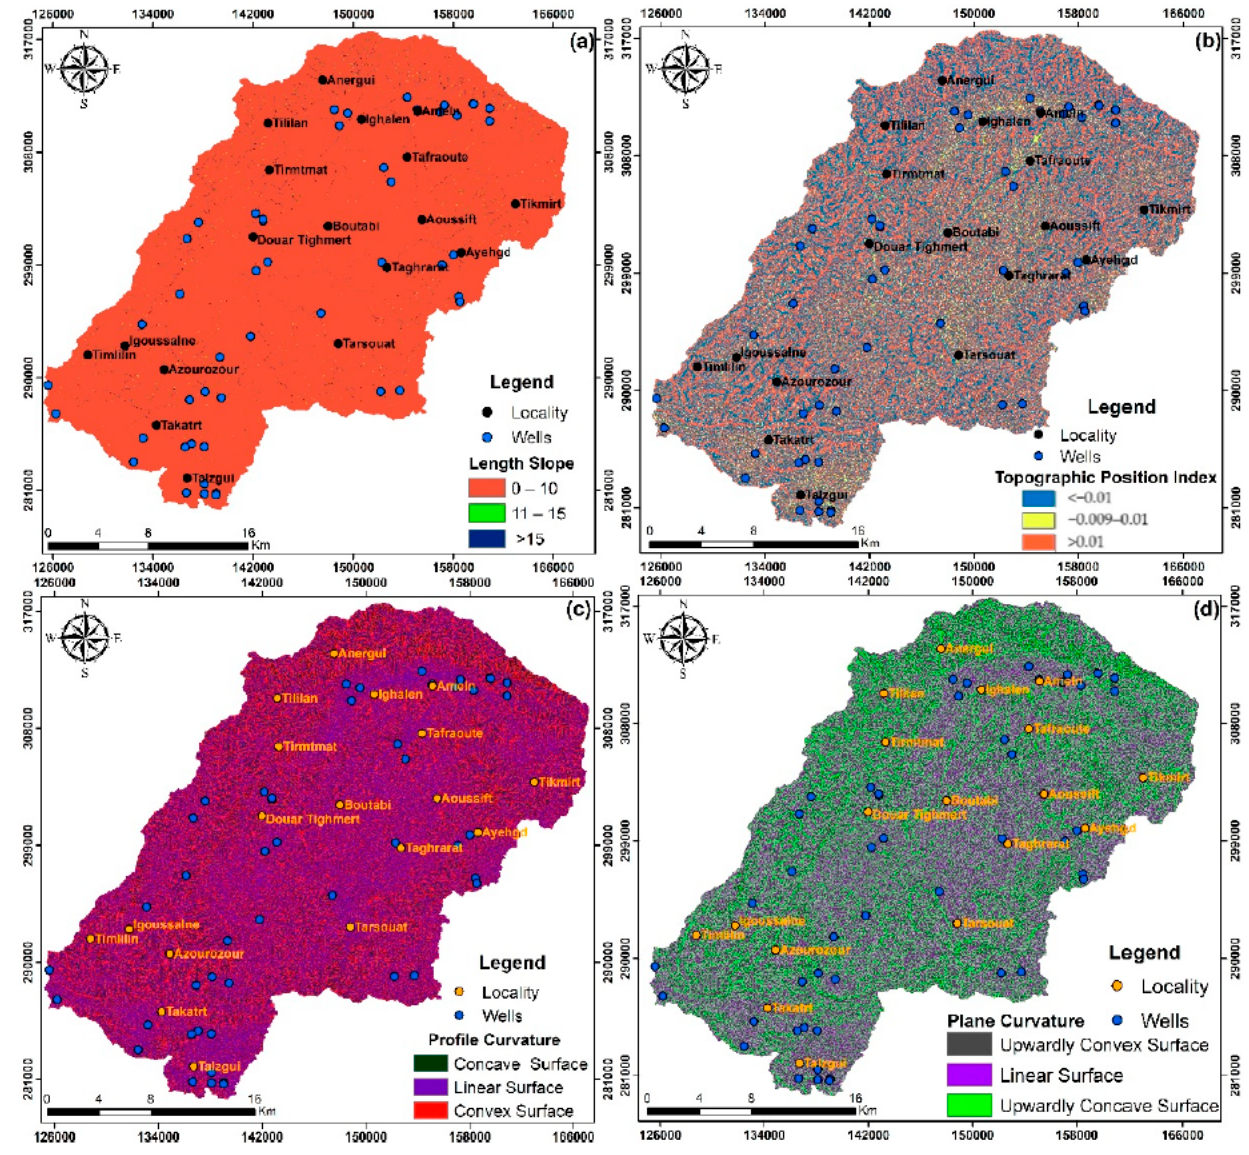
Figure 9. Topographical factors influencing groundwater. ( a ) Length slope; ( b ) Topographic position index; ( c ) Profile curvature; ( d ) Plan curvature.